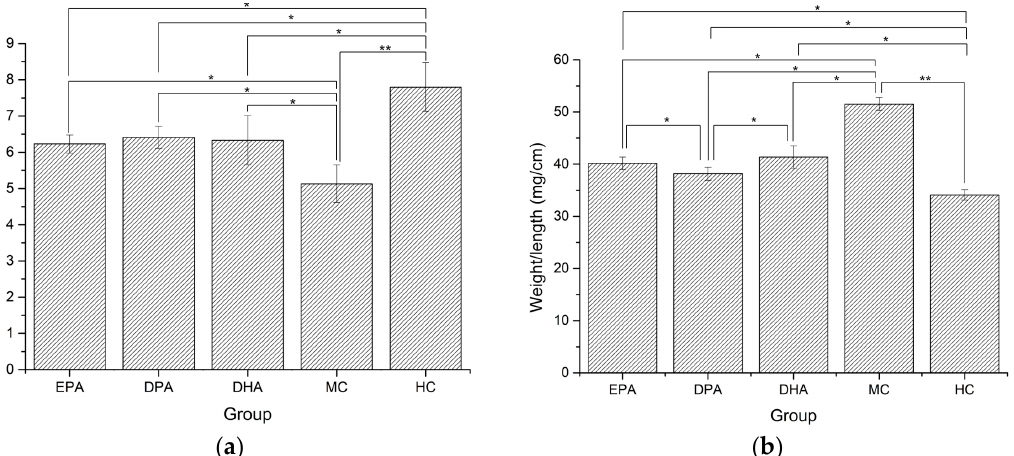
Figure 2. Changes in colon length ( a ) and weight/length ratio ( b ) during the DSS treatment. Note: EPA, DPA, DHA, MC, HC represent EPA group, DPA group, DHA group, model control group, health control group, respectively. * p < 0.05, ** p < 0.01. health control group, respectively. * p < 0.05, ** p <